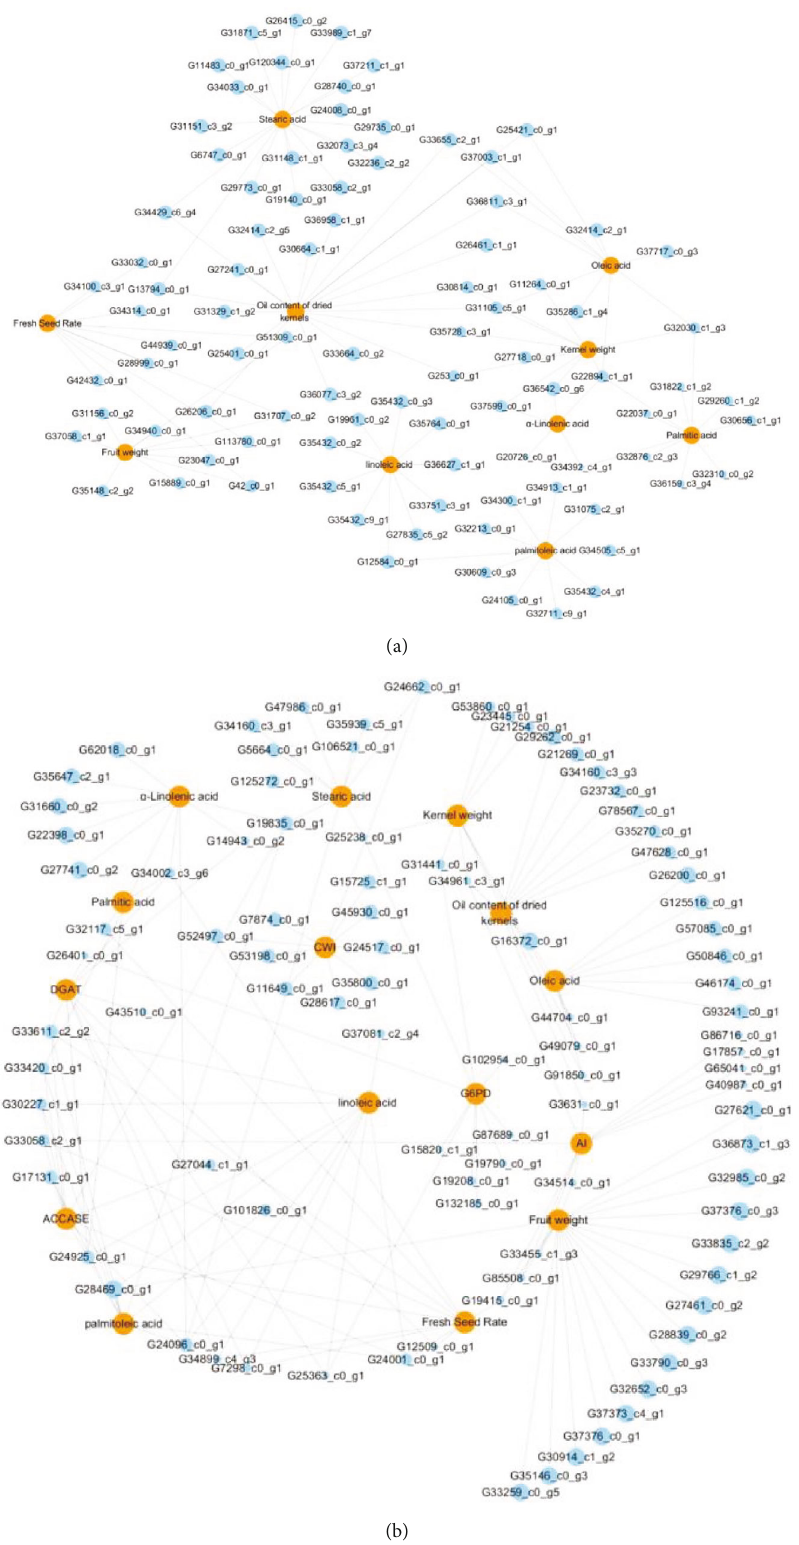
Figure 5: Correlation network diagram of gene and character. Red nodes represent character, and blue nodes represent gene. (a) Character- gene network of XL106; (b) character-gene network of